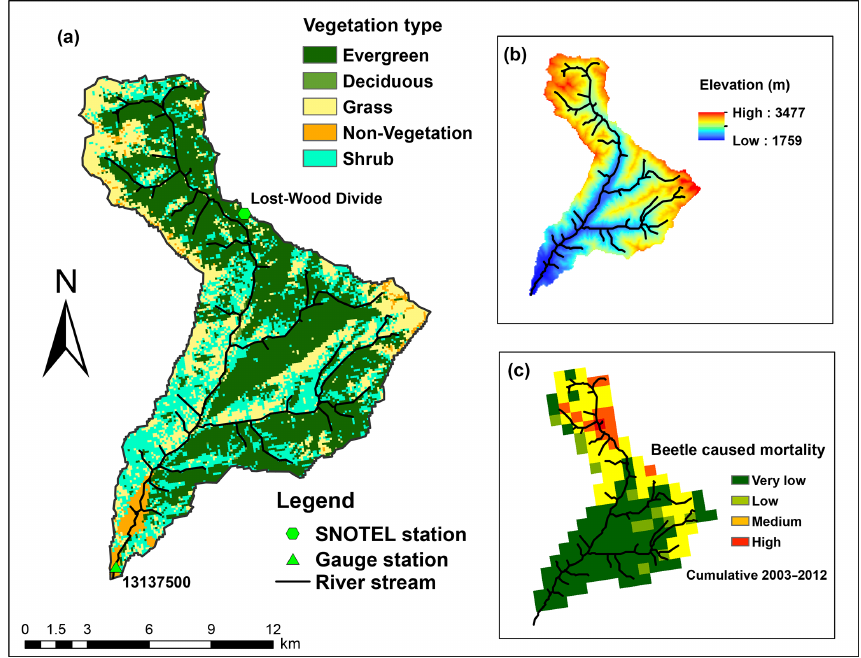
Figure 2. Land cover, elevation, and tree mortality for Trail Creek: (a) is a land cover map showing the main vegetation types, (b) shows the elevation gradient, and (c) shows the severity of beetle-caused tree mortality (during the period 2003–2012; Meddens et al., 2012). Note that, for our modeling experiments, we prescribed that the beetle outbreak occurred uniformly across the evergreen patches instead of using historical beetle outbreak